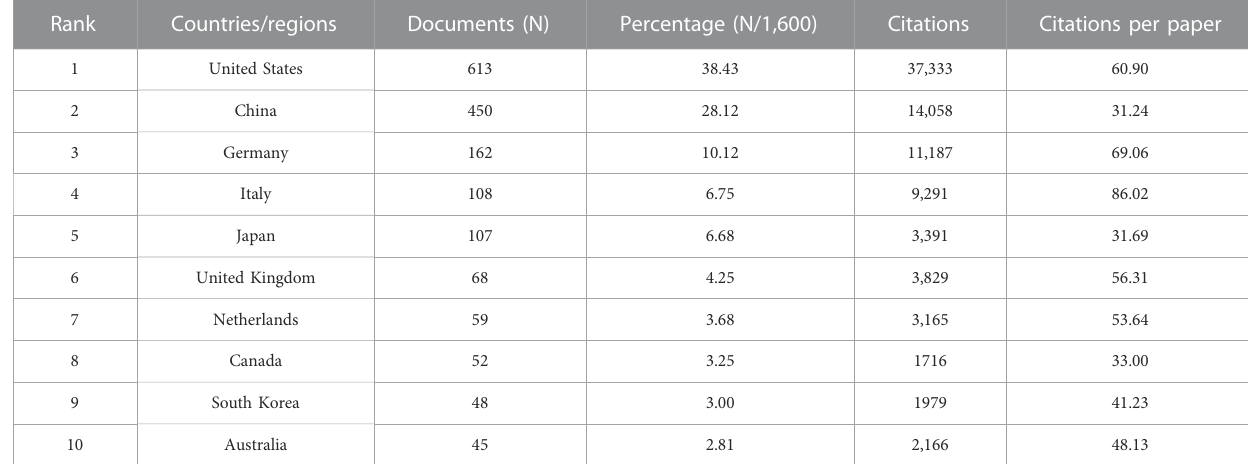
TABLE 1 Top 10 productive countries/regions related to AKI in kidney repair.